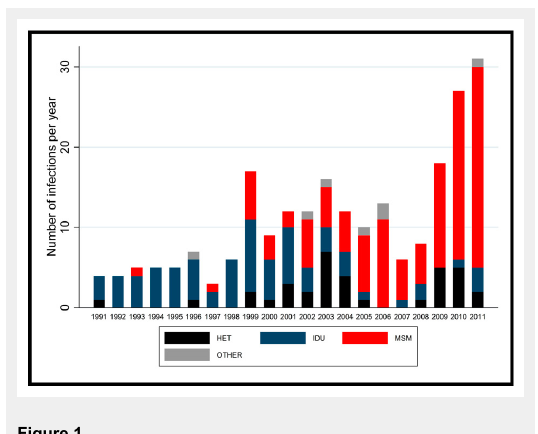
Incident HCV infections by transmission route in the Swiss HIV Cohort Study.